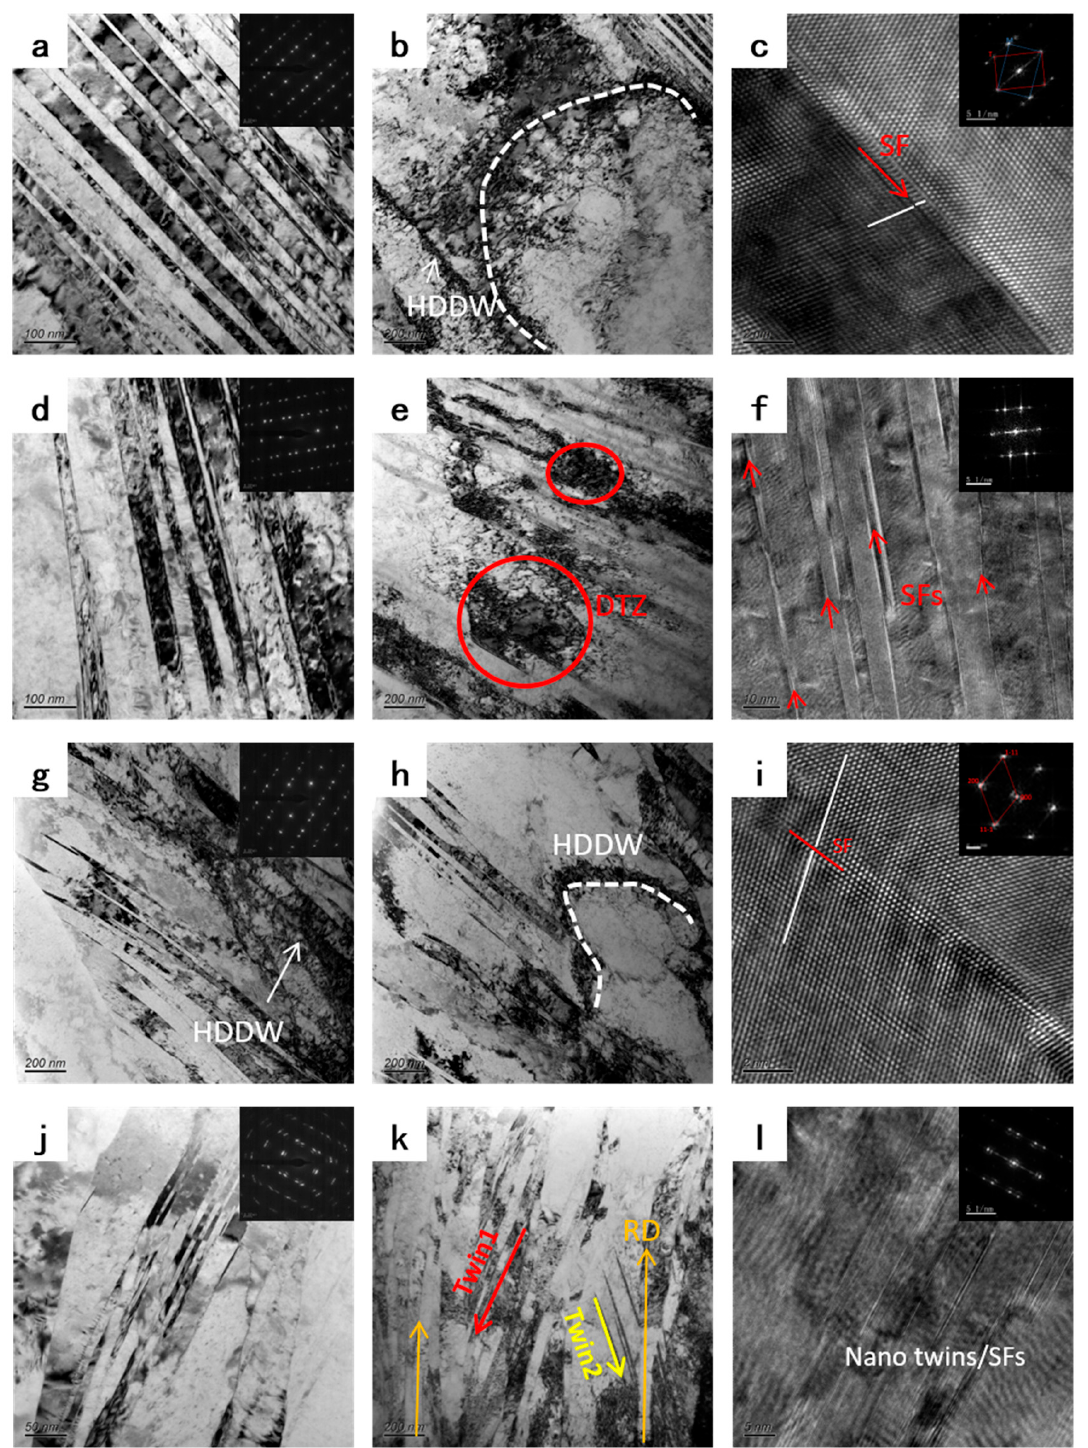
Figure 9. TEM images showing the microstructural evolution of RTR samples with different reduc- tions: ( a – c ) RTR30, ( d – f ) RTR60, ( g – i ) RTR80, and ( j – l ) RTR90.